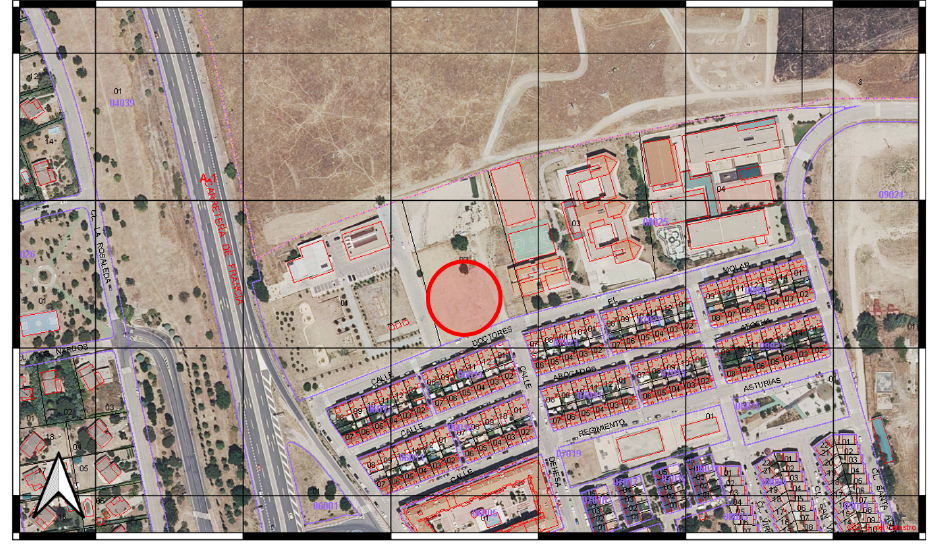
Figure 1. Experimental plot in El Molar (north of Madrid, Spain). Zebra frame of 100 m.